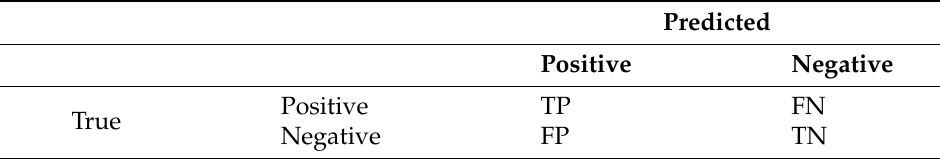
Table 3. Confusion